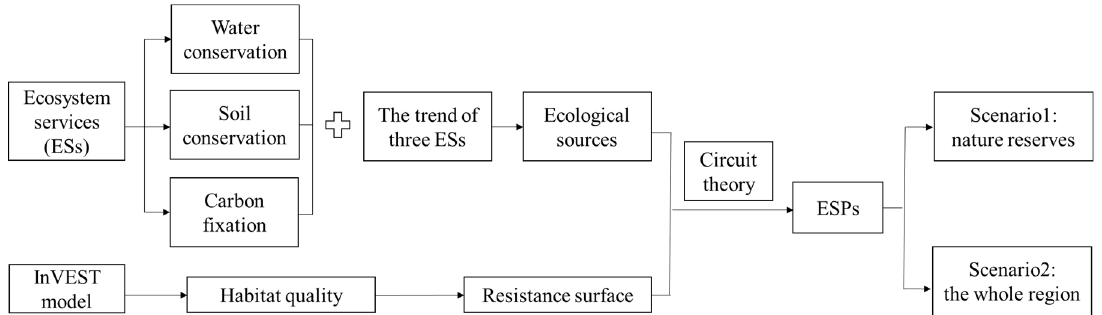
Figure 2. Flowchart on identifying ecological security patterns (ESPs).